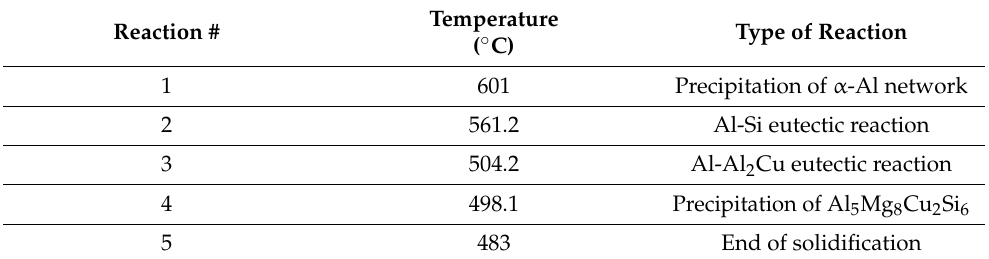
Table 4. Expected phases in C alloy solidified at 0.8 ◦ C/s.